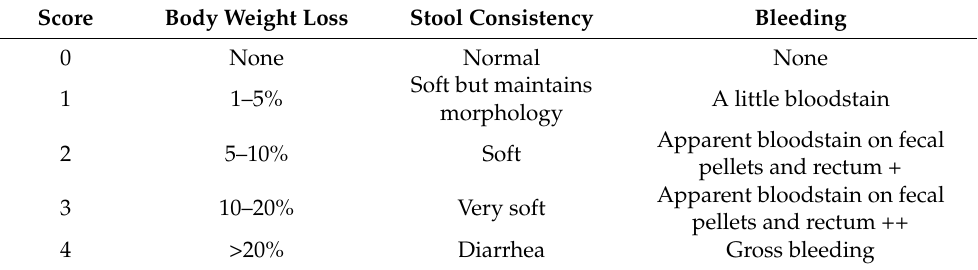
Table 1. Scoring system for the calculation of disease activity index (DAI).